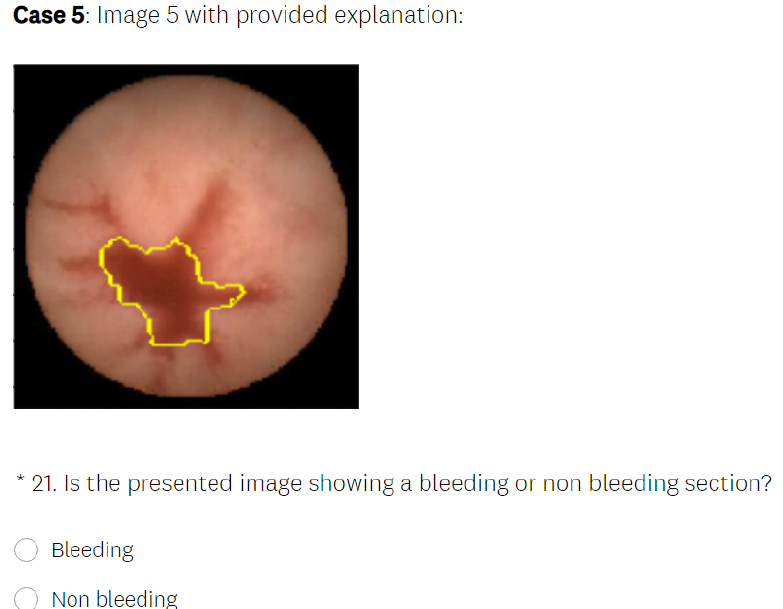
Figure 13. LIME explanations in the user study.